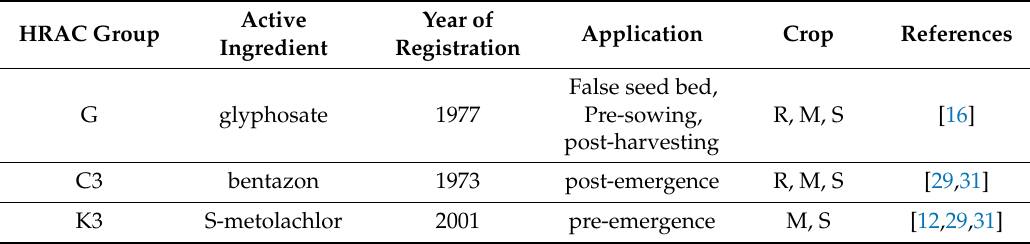
Table 3. Active ingredients authorized in Italy in rice (R), maize (M) or soybean (S) e ff ective to control ALS-resistant C.